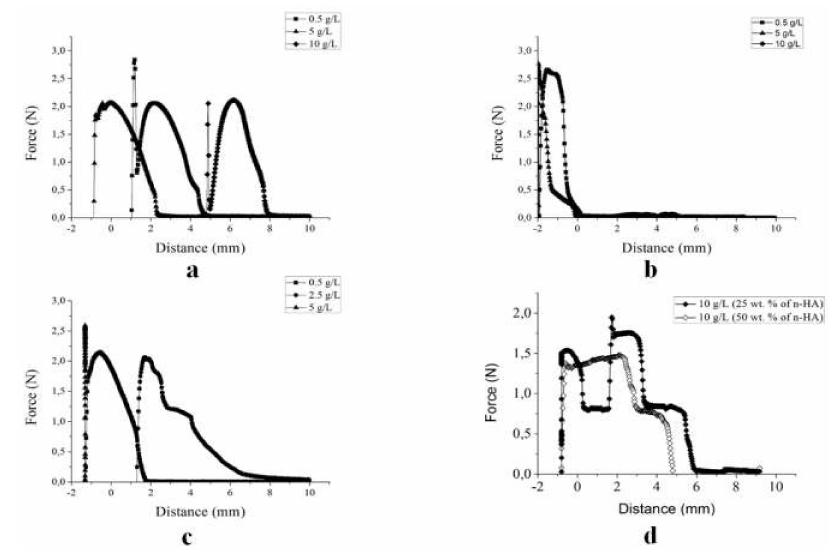
Figure 3. Profiles of mucoadhesion of HA dispersions on the mucin tablets. ( a ) I-MM HA ( b ) H-MM, ( c ) nanoparticles ( c ) and ( d ) mixed, at compositions of 0.5 g / L ( ), 2.5 g / L ( ), 5 g / L ( ) and 10 g / L ( ,